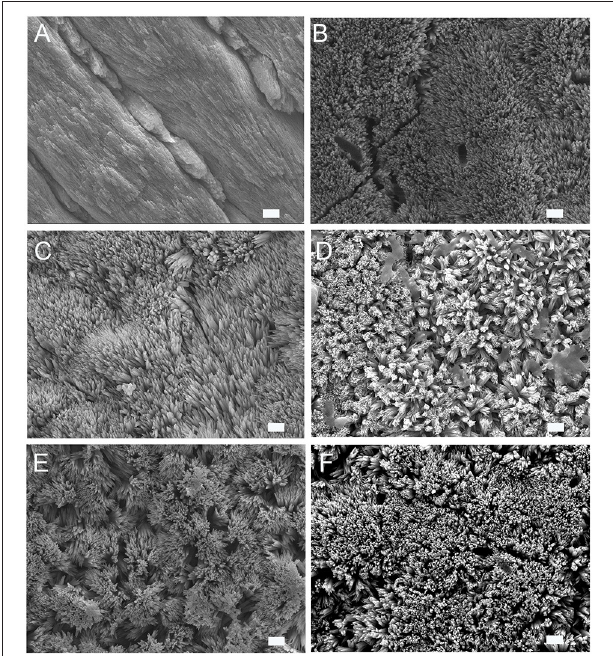
FIGURE 1 | SEM images of demineralized enamel surface showing clear outlines of enamel prisms/rods with remnants of inter-rods (A) . HAP crystals grown on demineralized enamel after 3 days of incubation at pH 7.0, 37 ◦ C in artificial saliva (control) (B) , with P32 (C) , P32-CS (D) , P26 (E) , P26-CS (F) (scale = 1